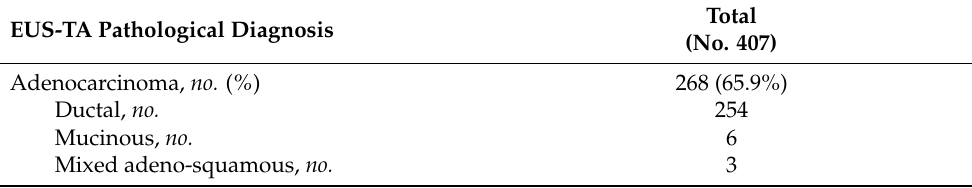
Table 2. Pathological diagnosis of EUS-tissue